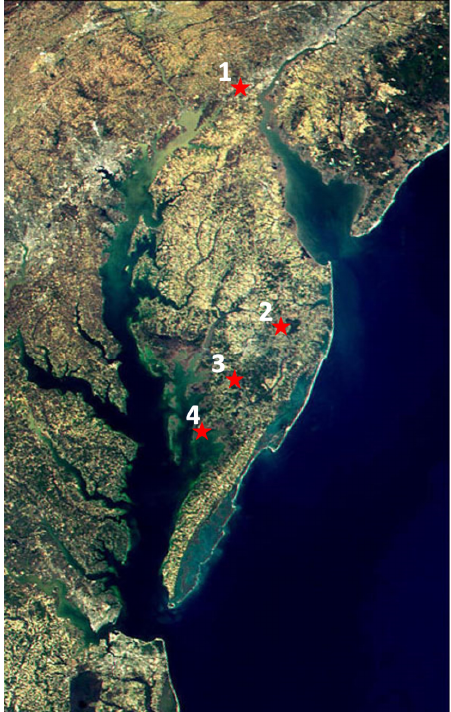
Figure 1. Modified satellite image of the Chesapeake Bay, image credit Jacques Descloitres, MODIS Land Science Team, NASA [26]. Stars indicate agricultural composite soil sampling locations on the Delmarva Peninsula. (1) Newark, Delaware: CGAp; (2) Parsonsburg, Maryland: T1 and T2; (3) Princess Anne, Maryland: Manure Shed (MS) and SLF2; (4) Crisfield, Maryland: CFT, MFT, EFT, and Ditch.